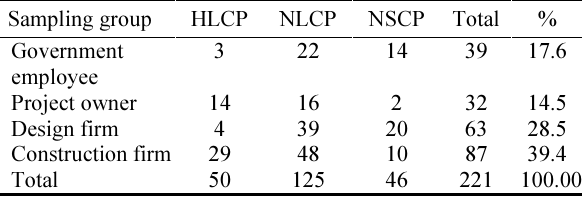
Table 3. Analysis of the sampling